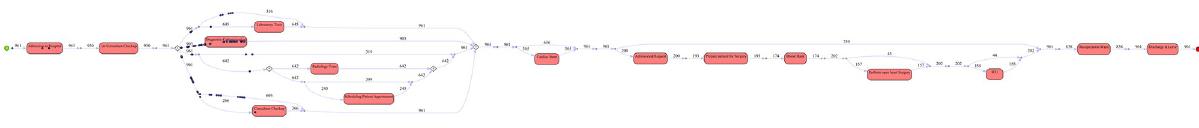
Fig 21. Patients’ distribution among hospital services.